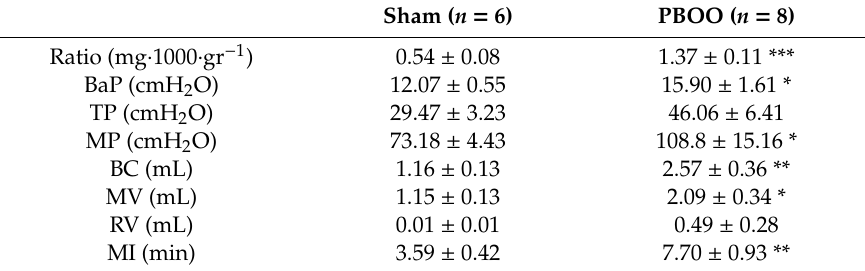
Figure 1. Comparison of bladder weight and micturition pressure (MP), with representative tracings, in sham rats and rats with partial bladder outlet obstruction (PBOO). ( A ). Ratio of bladder weight to body weight. ( B ). MP of sham rats and rats with PBOO. ( C ). Tracings of sham rats. ( D ). Tracings of rats with PBOO. The bladder weight and MP of rats with PBOO were significantly higher than those of sham rats. Representative tracings show the higher MP in rats with PBOO compared to sham rats. Pves: intravesical pressure. Vol: volume. *: p < 0.05 and ****: p < 0.0001, compared to sham. Table 1. Comparison of cystometric parameters between the sham rats and rats with partial bladder outlet obstruction